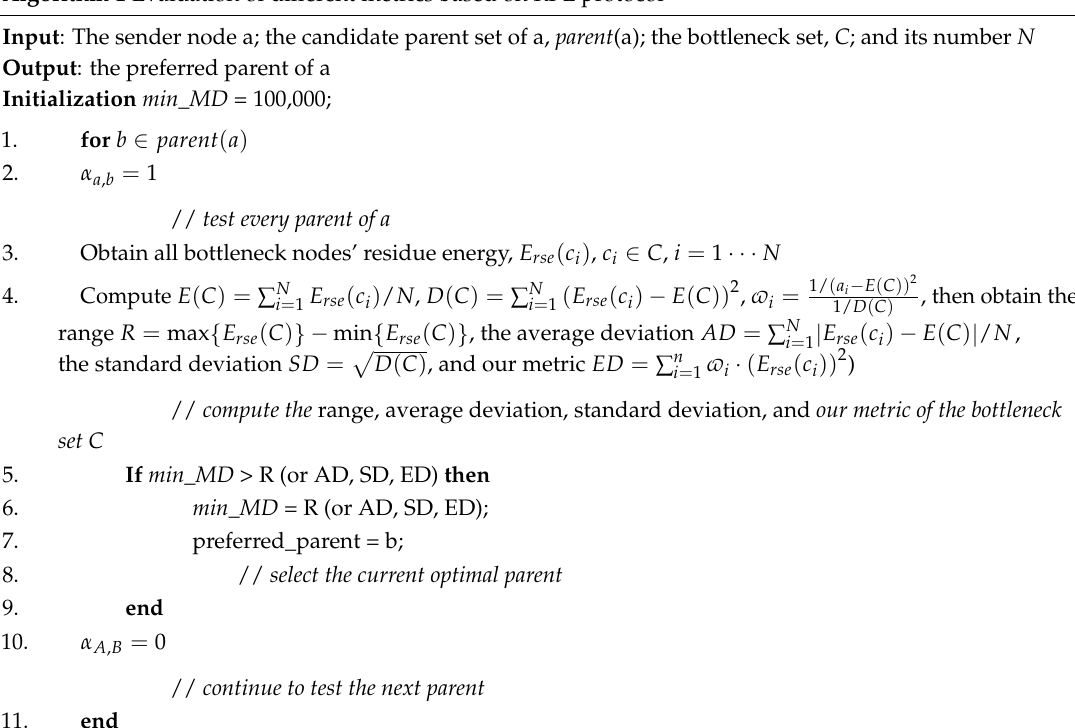
Algorithm 1 Evaluation of different metrics based on RPL protocol